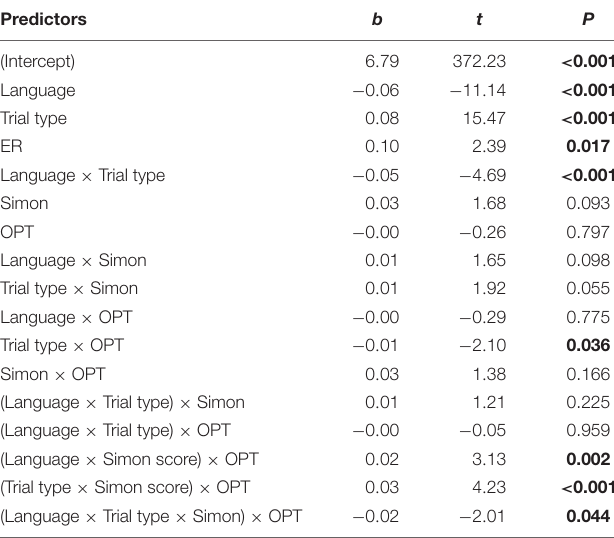
TABLE 5 | Estimated coefficients (logRT) from the mixed-effects model for examining the mixing cost.